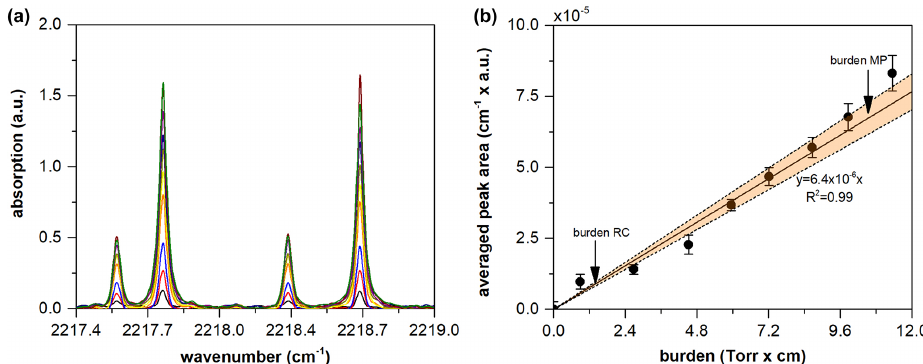
Figure 2. Absorption of N 2 O with respect to cell pressure (a) . The curve-of-growth plot for the corresponding peaks (b) . Averaged peak areas after instrumental line shape (ILS) deconvolutions are shown with respect to the absorption burden (pressure × optical path length (OPL)). Without ILS deconvolution, no linearity of fit was obtained. A weighted least squares method was employed to fit the measured dataset with a straight line crossing the origin. The orange areas represent the confidence bands (at k = 2) of the fitted line. The curve-of-growth analysis shows that the OPL calibration was valid for the cell-to-cell comparison method by occurring within the linear region of the curve-of-growth